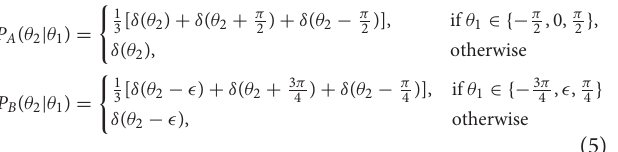
5 (dashed lines) and N 11 (solid lines) and for several values of decoherence κ = =